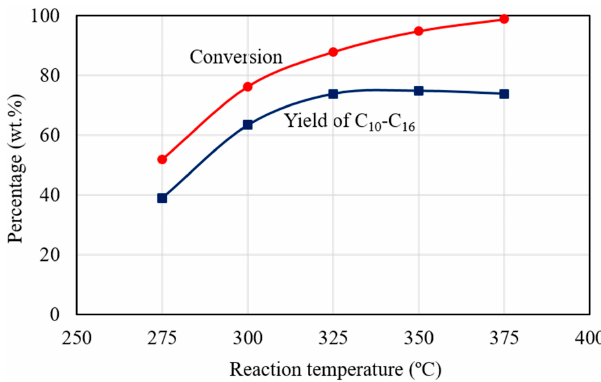
Figure 10. The dependence of C 15 H 31 COOC 16 H 33 conversion and C 10 –C 16 hydrocarbon yield on reaction temperature for the catalytic deoxygenation of C 15 H 31 COOC 16 H 33 in N 2 atmosphere, for 2 h, over the 1 wt.% Pd/Mg(Al)O catalyst. Reaction conditions: C 15 H 31 COOC 16 H 33 : 5 g; catalyst: 0.2 g; N 2 pressure at 25 °C: 0.9 MPa.